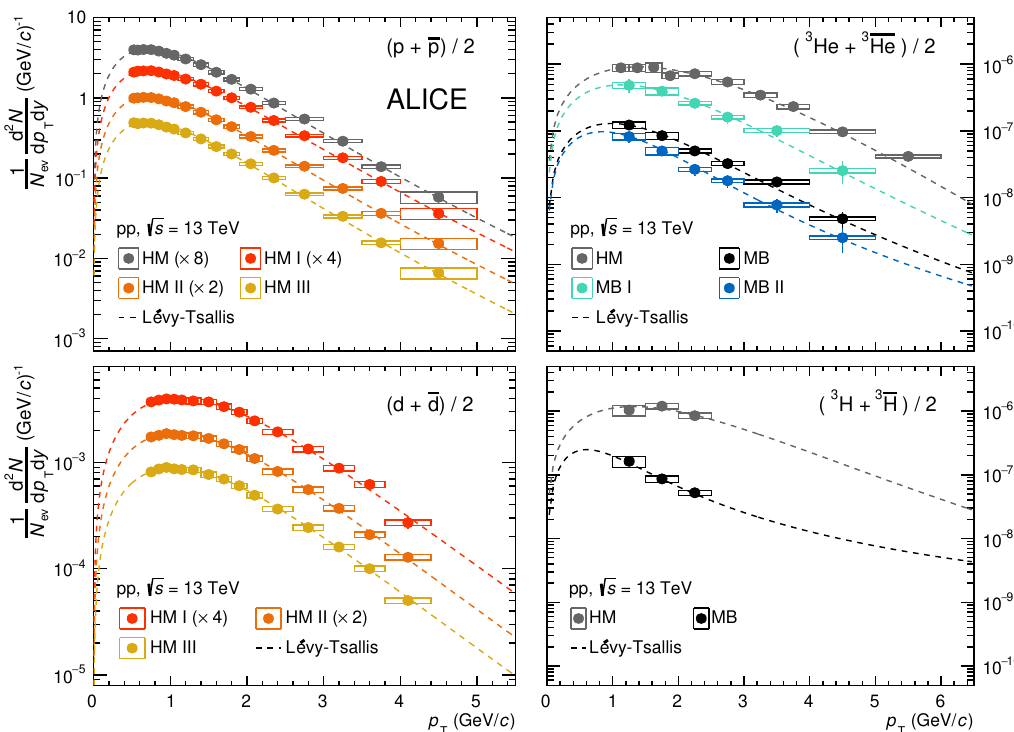
Figure 1. Transverse-momentum spectra of (anti)protons, (anti)deuterons, (anti)helion, and √ (anti)triton, measured in HM and MB pp collisions at s = 13 TeV at midrapidity ( | y | < 0 . 5) . The results are shown in the multiplicity classes reported in table 2. Vertical bars and boxes represent statistical and systematic uncertainties, respectively. The dashed lines are individual fits with a Lévy-Tsallis